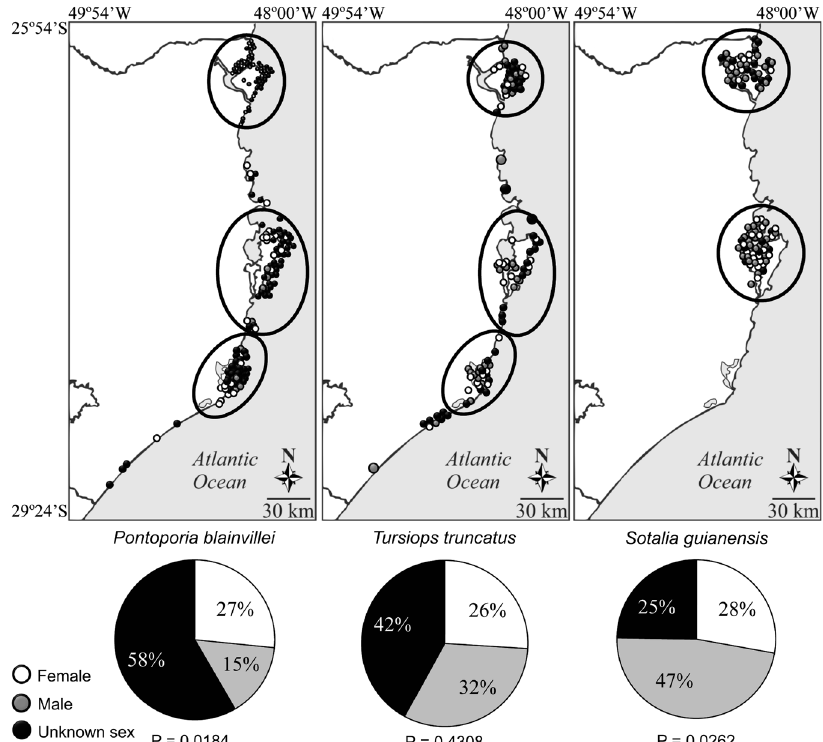
Figure 5. Spatial and sexual distribution of stranding records of Pontoporia blainvillei , Tursiops truncatus and Sotalia guianensis along Santa Catarina coast from 1983 to